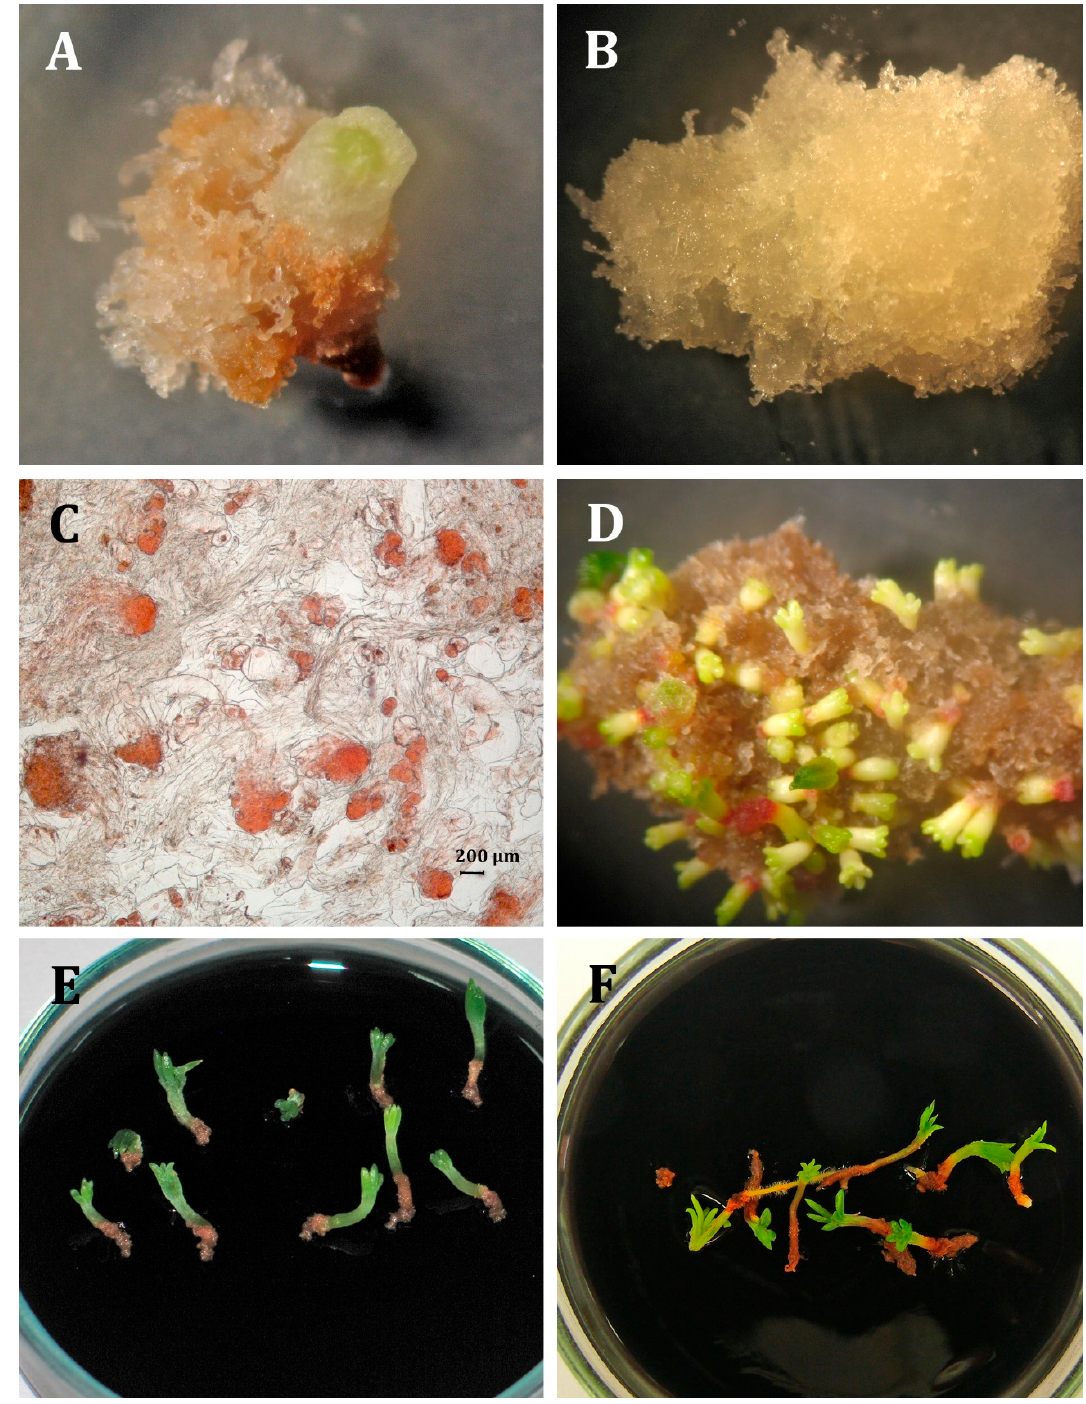
Figure 2. Somatic embryogenesis in P. omorika . ( A ) Embryogenic masses developed on the explant. ( B ) Embryogenic cultures growing on the proliferation medium. ( C ) Proembryogenic structures (proembryos) present in the embryogenic tissues after staining with acetocarmine. ( D ) Somatic embryos going through the maturation process. ( E ) Germinated somatic embryos. ( F ) Somatic seedlings with developed first needles suitable for